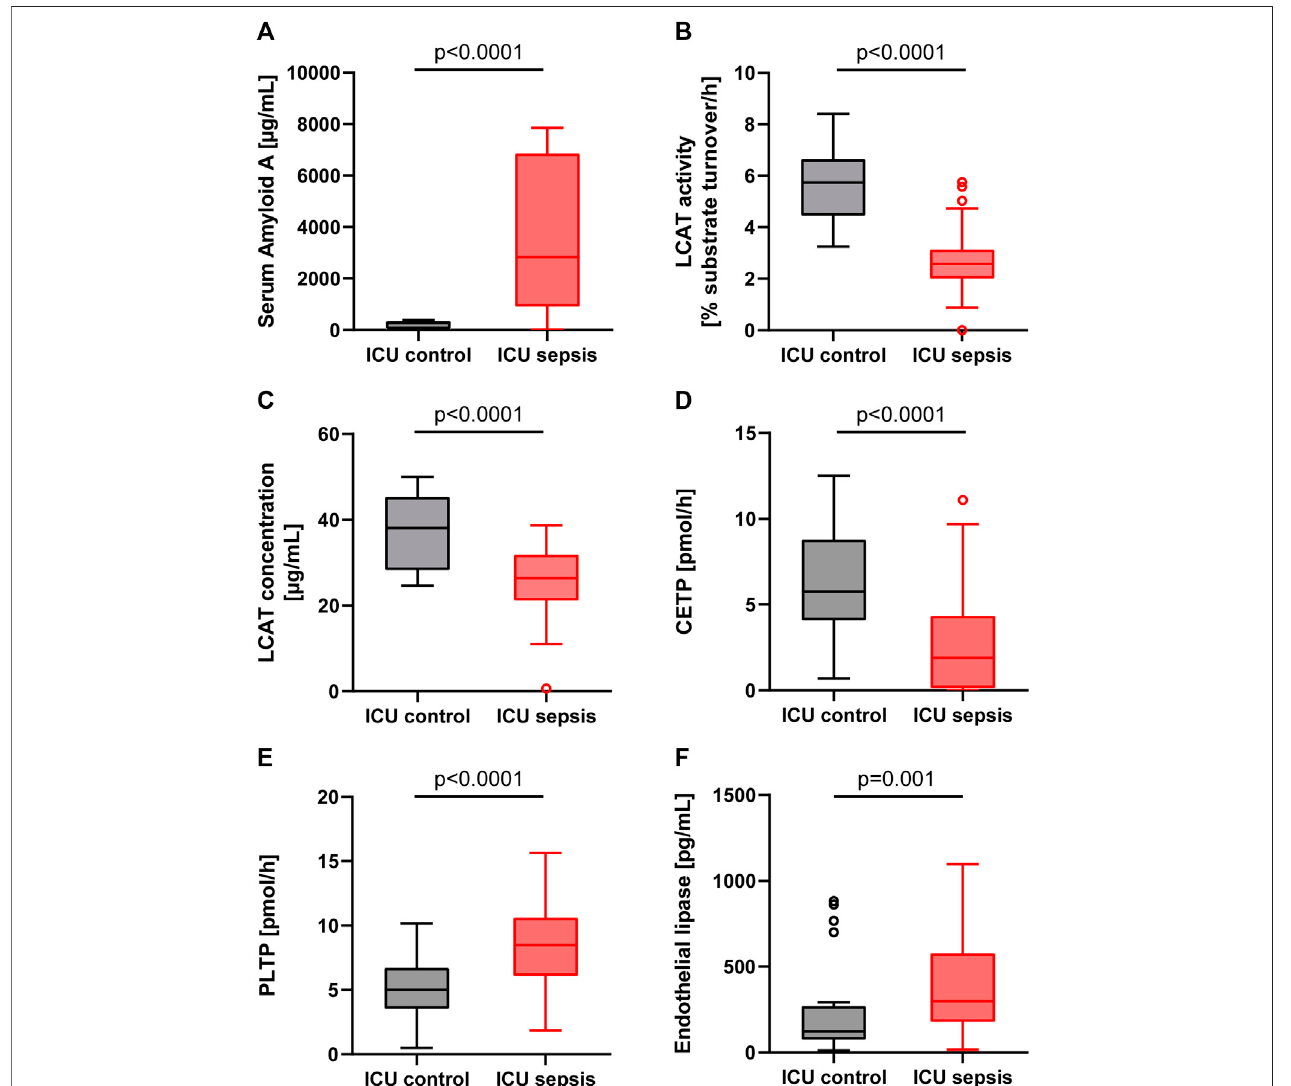
FIGURE1| Boxplots fortheICUcontrolgroup(patientswithoutsepsisorbacteremia)andICUsepsisgroup. (A) :SerumAmyloidA(SAA). (B) :Lecithin-cholesterol acyltransferase (LCAT) activity. (C) : Lecithin-cholesterol acyltransferase (LCAT) concentration. (D) : Cholesteryl ester transfer protein (CETP). (E) : Phospholipid transfer protein (PLTP). (F) : Endothelial lipase (EL). Note that in the EL boxplot two outliers in the sepsis group (17,436 and 1,659 pg/ml) and one outlier in the control group (2,839 pg/ml) are not displayed.